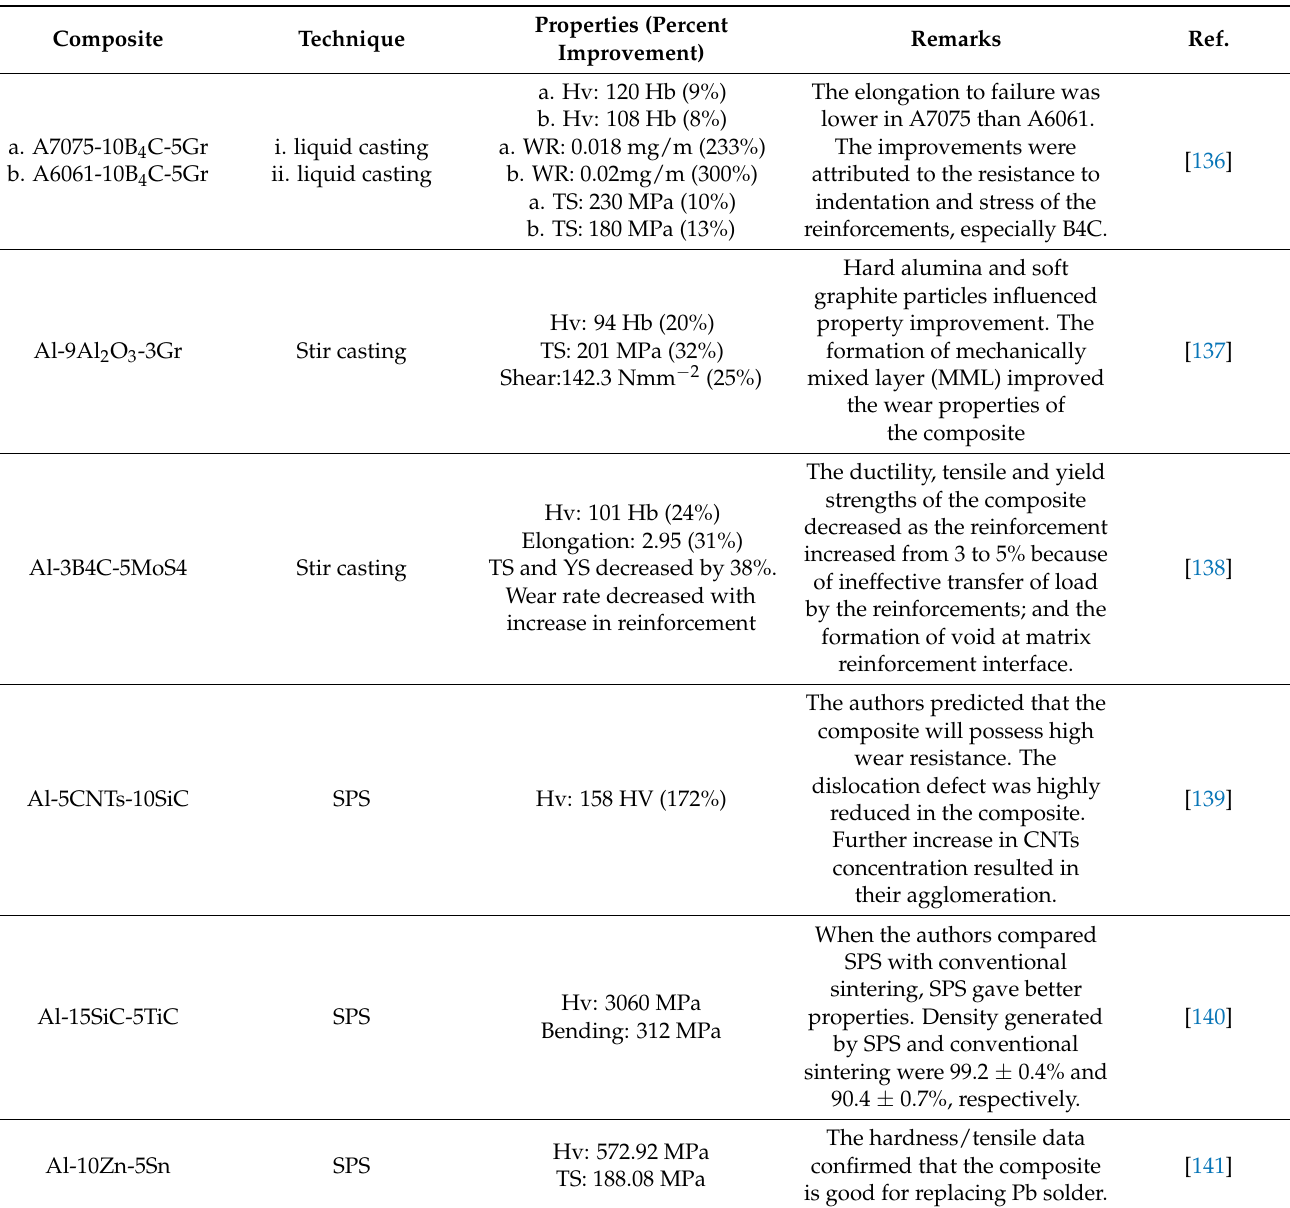
Table 2. Properties of aluminium hybrid composite